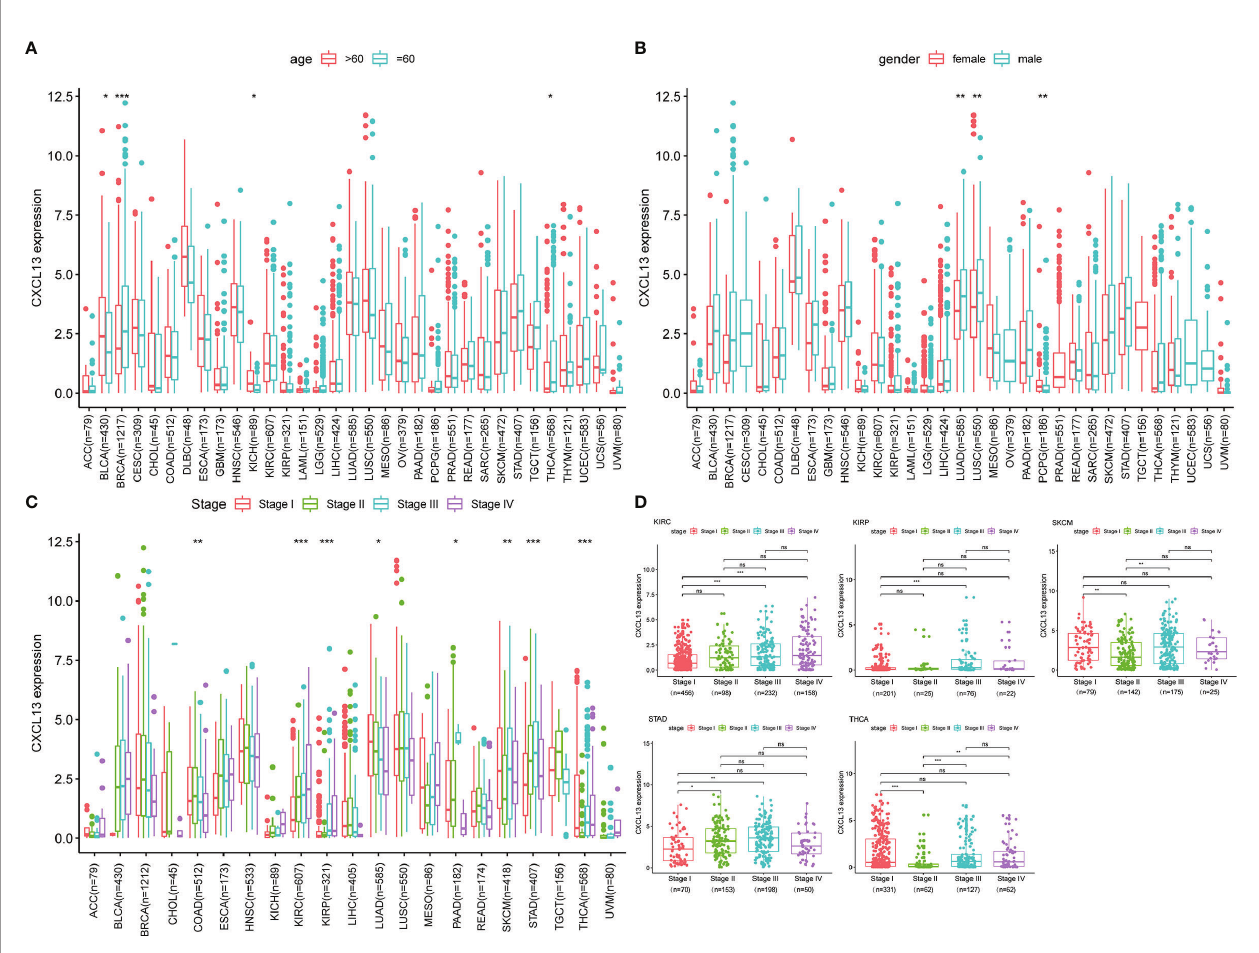
FIGURE 3 | TheclinicalcorrelationofCXCL13. (A) representsthecorrelationbetweenageandCXCL13; (B) showsthecorrelationbetweengenderandCXCL13; (C) represents thecorrelationbetweentumorstageandCXCL13; (D) demonstratesthecorrelationbetweenCXCL13andstagesbetweenpairwisegroups.*P<0.05,**P<0.01,***P<0.001. ns,nosigni fi